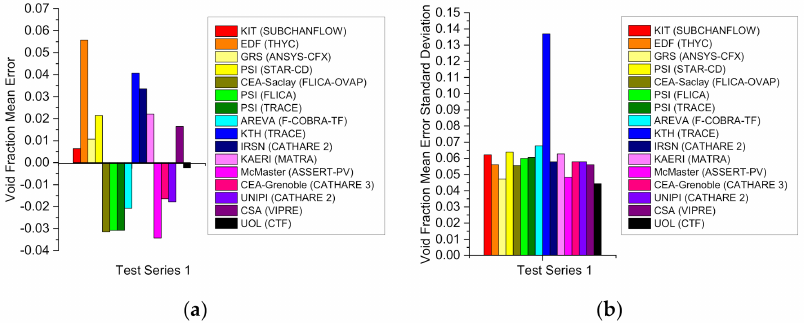
Figure 5. ( a ) Codes void fraction mean errors; ( b ) codes void fraction error standard